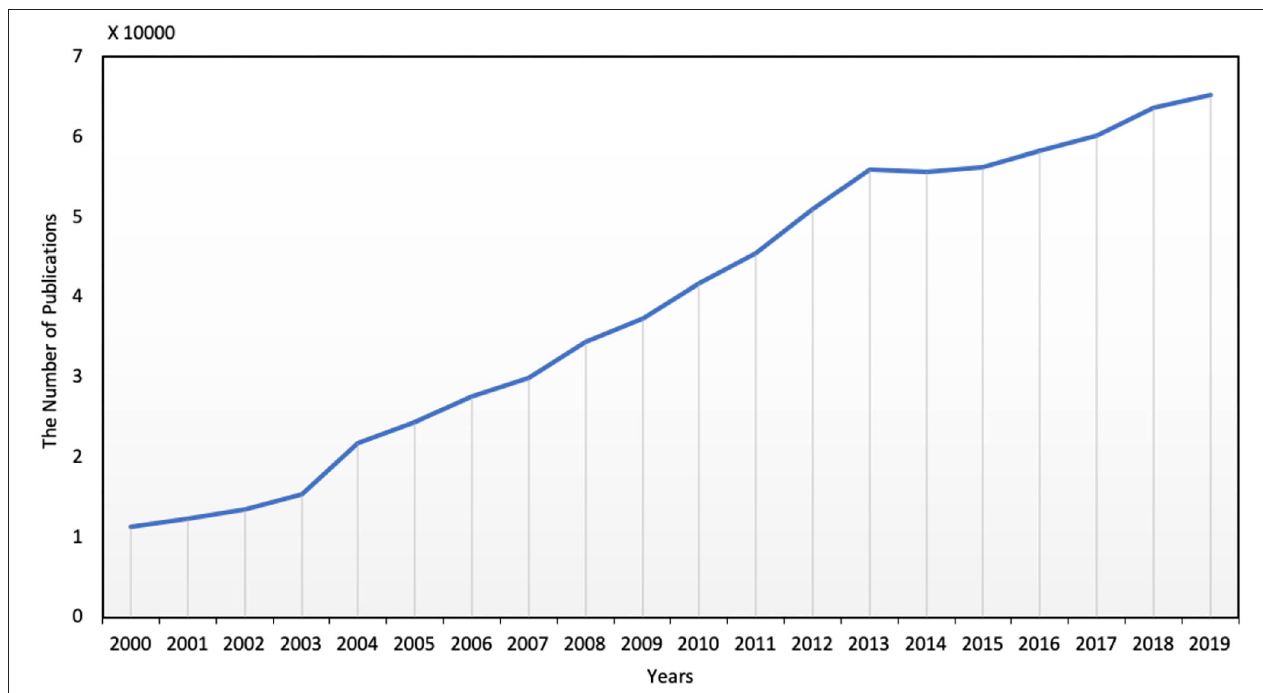
FIGURE 4 | The number of publications for student performance prediction per